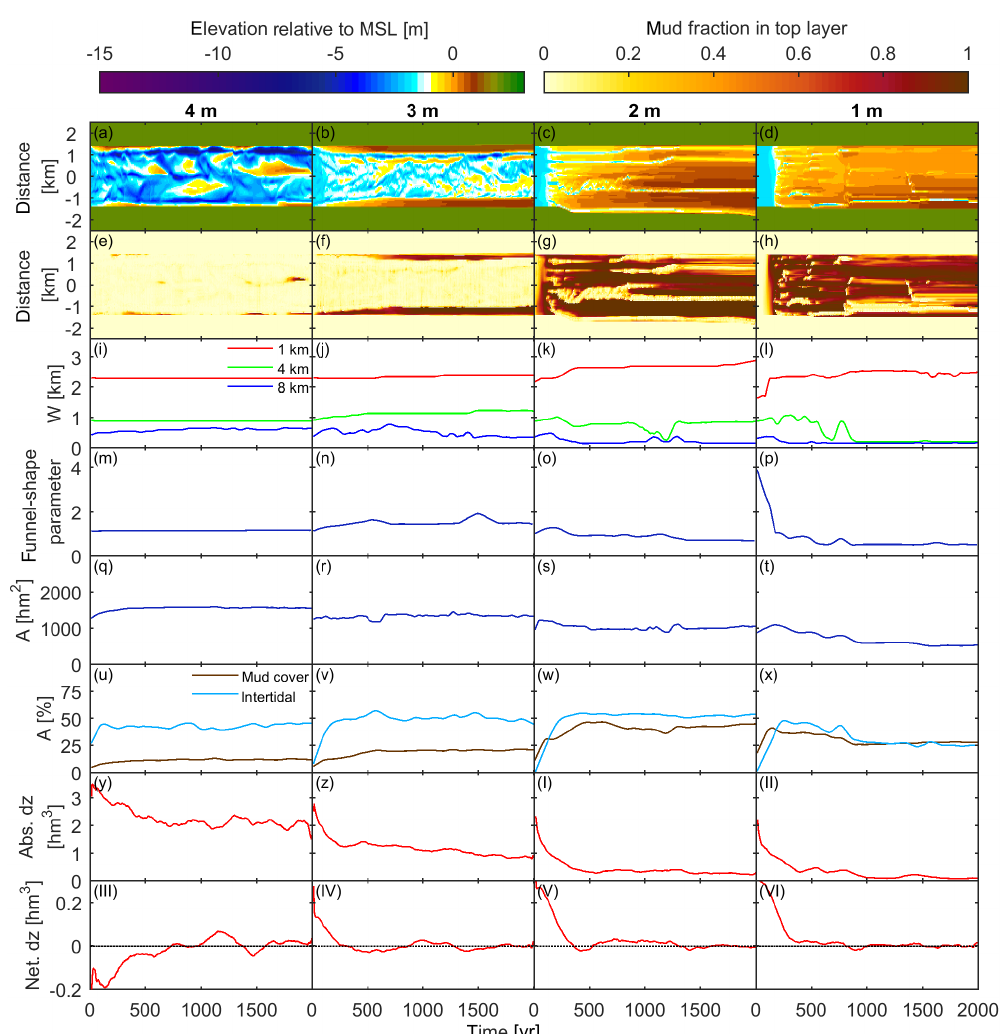
Figure A9. Hydrodynamics and morphodynamics over time for estuaries with different tidal ranges. From left to right (columns): model with 4 (06), 3 (default, 01), 2 (05) and 1m (20) tidal range. (a–d) Bathymetry of the cross section at the mouth plotted over time, (e– h) mud fraction in the top layer of the cross section at the mouth, (i–l) estuary width at 1, 4 and 8km from the mouth, (m–p) funnel-shape parameter, (q–t) estuarine surface area, (u–x) intertidal area and mud in the bed relative to the total area, (y–II) absolute bed level change and (III–VI) net bed level